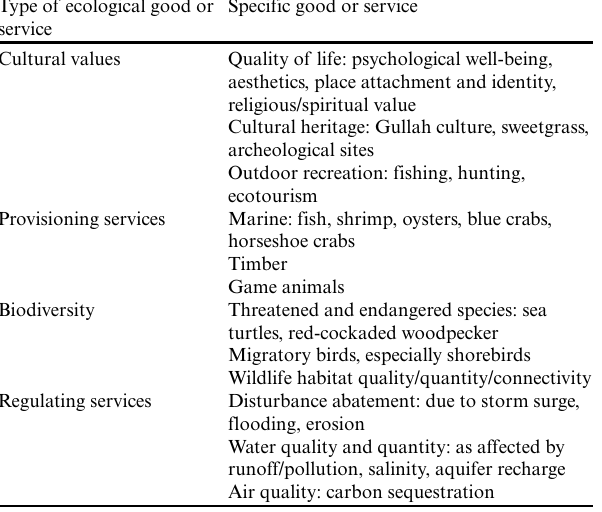
Table 1 . Summary of ecological goods and services of value identified by participants of the Cape Romain Partnership for Coastal Protection.